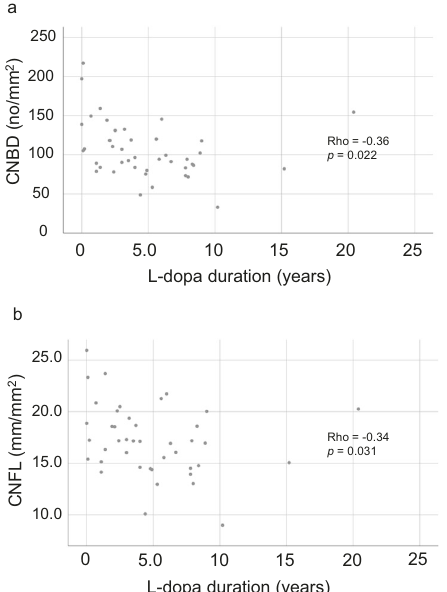
Fig. 2 Associations between corneal parameters and L -dopa therapy. The duration of L -dopa therapy associates with CNBD ( a ) and CNFL ( b ). Correlation coef fi cients and p -values calculated with partial Spearman ’ s rank order correlation adjusting for age and sex (CNBD: ρ = − 0.36, p = 0.022), and age (CNFL: ρ = − 0.34, p = 0.031), respectively. p -Values not adjusted for multiple comparisons.